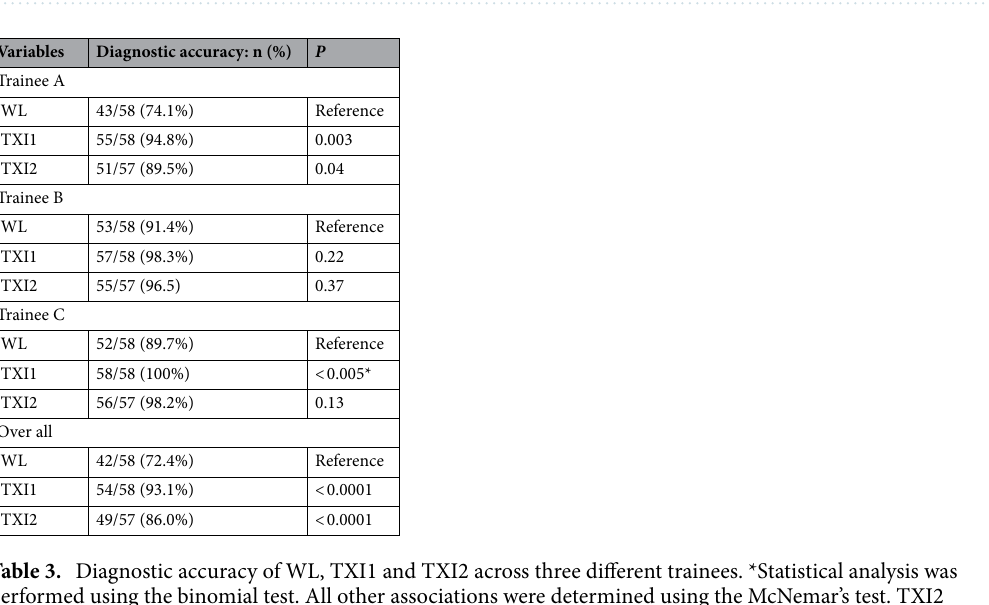
Figure 2. Color difference assessment. Annotation of four matched adjacent and intra-tumoral points and color difference analysis (upper). An EGC lesions is observed as slightly reddish flat area in the lesser curvature of the upper gastric body. Colors of four matched adjacent (light green cross marks) and intra-tumoral points (light blue cross marks) were annotated in proximal, distal, anterior and posterior sites in WL (upper left), TXI1 (upper middle), and TXI2 (upper right) images. Then, ΔE of four matched adjacent and intra-tumoral points were averaged as the mean ΔE of each image. MeanΔE of four matched adjacent and intra-tumoral points were compared between WL, TXI1 and TXI2 (lower). Statistical analysis was performed using the Wilcoxon signed rank test.